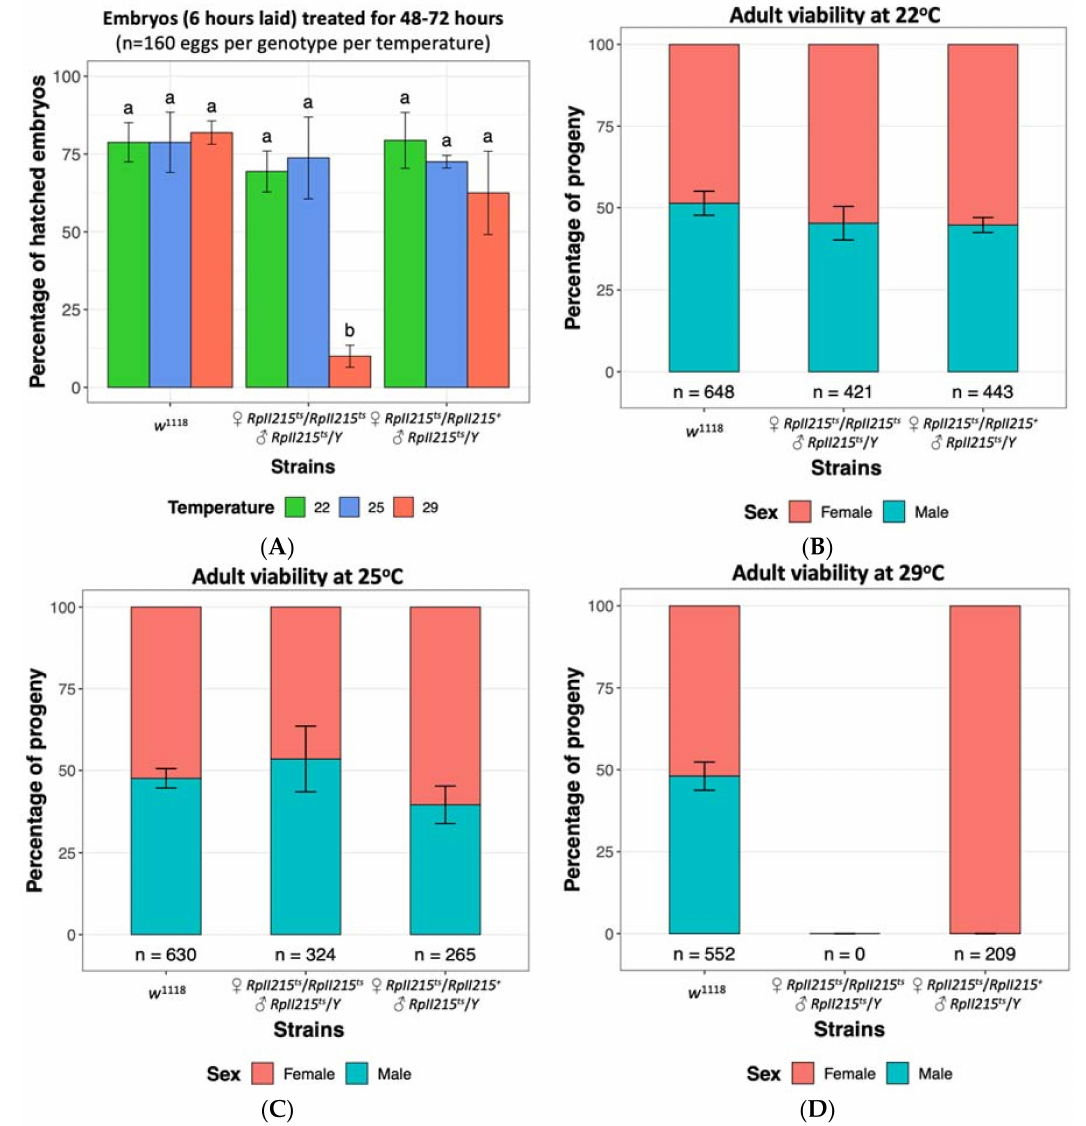
Figure 3. Embryo survival and fly viability at 22 ◦ C, 25 ◦ C and 29 ◦ C of Drosophila melanogaster control strain w 1118 RpII215 ts / RpII215 ts and RpII215 ts / Y ) [Bloomington [Bloomington Stock ID 51629], temperature sensitive RpII215 ts ( ♀ ♂ RpII215 ts / RpII215 + and RpII215 ts / Y ). ( A ) Embryos up to six hours old were Stock ID 34755] and their hybrid progeny ( ♀ ♂ collected and maintained at three temperatures for 48–72 h. The mean ( ± SD) percentage of hatched embryos from four replicate are shown, with 40 eggs per replicate. Significance was assessed using a two-way ANOVA followed by a Tukey post hoc test. The same letter above each bar indicates no significant difference ( p > 0.05). Observed female and male fly viability at ( B ) 22 ◦ C, ( C ) 25 ◦ C and ( D ) 29 ◦ C temperatures confirmed rearing at 29 ◦ C is lethal for homozygous females and hemizygous males, but not heterozygous females. Data is displayed as a percentage with the total number of flies indicated below each bar. Standard deviations from six replicates are shown (Supplementary Methods